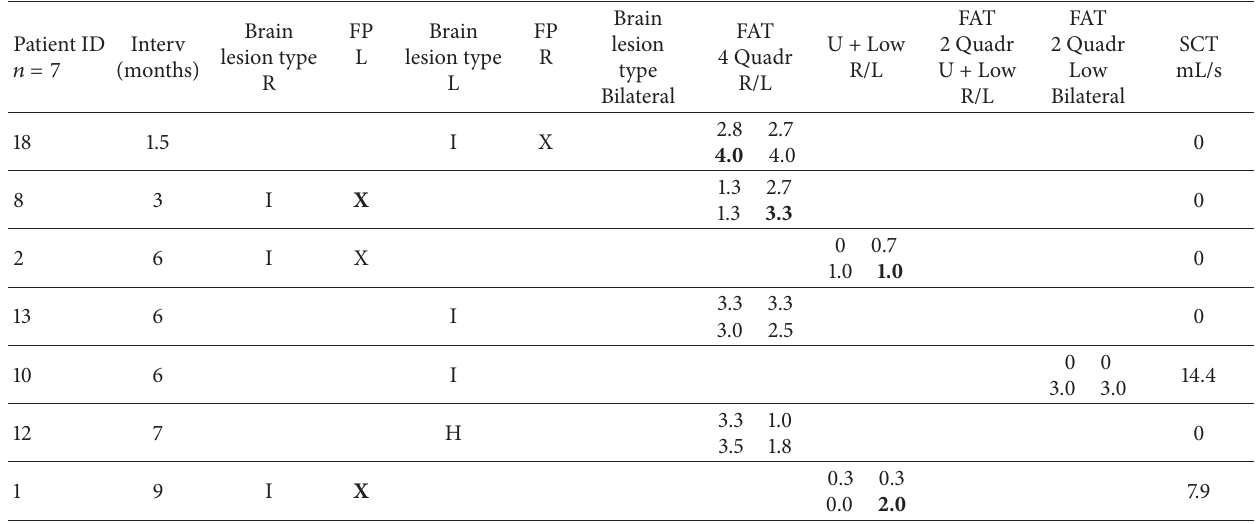
Table 2: Four-quadrant (upper, lower, right, and left) facial function in Group B (status months after stroke). Individual data are given for each patients with stroke and dysphagia ( 𝑛 = 7